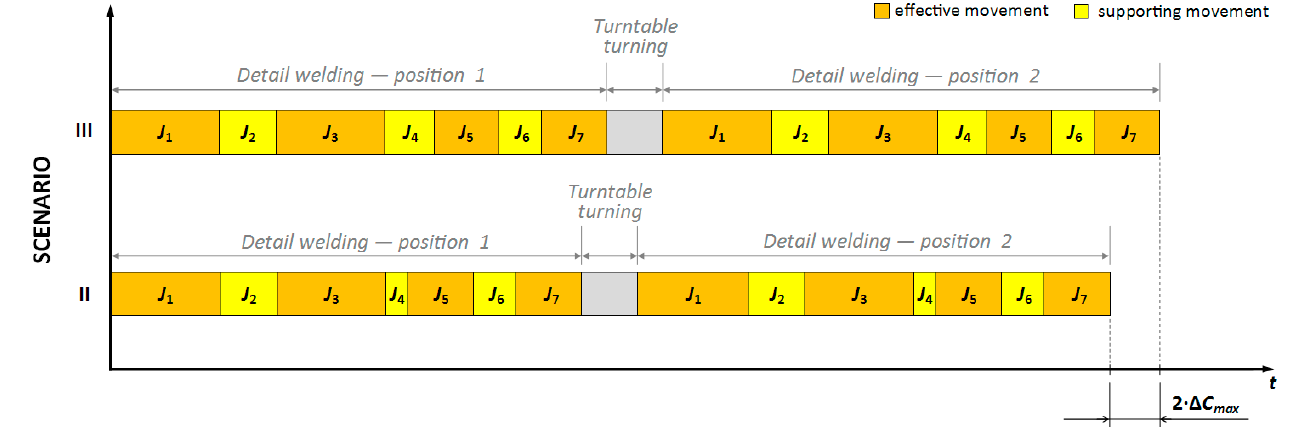
Figure 6. Benefits of the obtained time reduction of the process. Upon analyzing Figure 6, it should be stated that while in the case of the production of tens of pieces, the time saving will be only a few minutes, in the case of the production